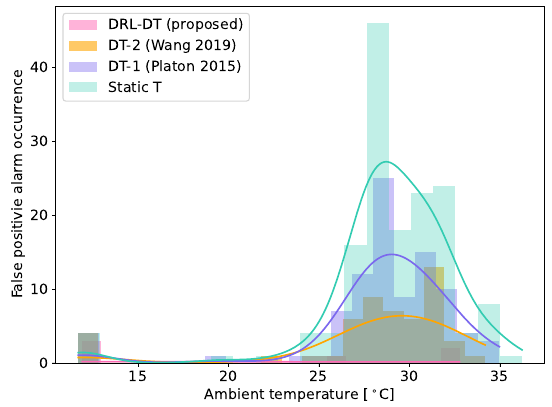
Figure 17. False positive alarm occurrences depending on ambient temperature